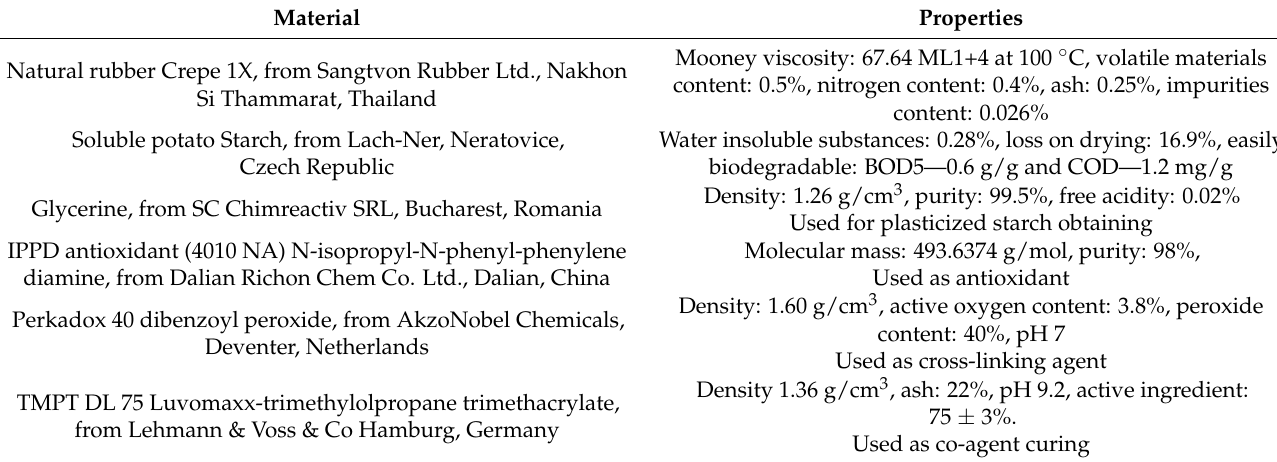
Table 1. Physical and chemical characteristics of raw materials.